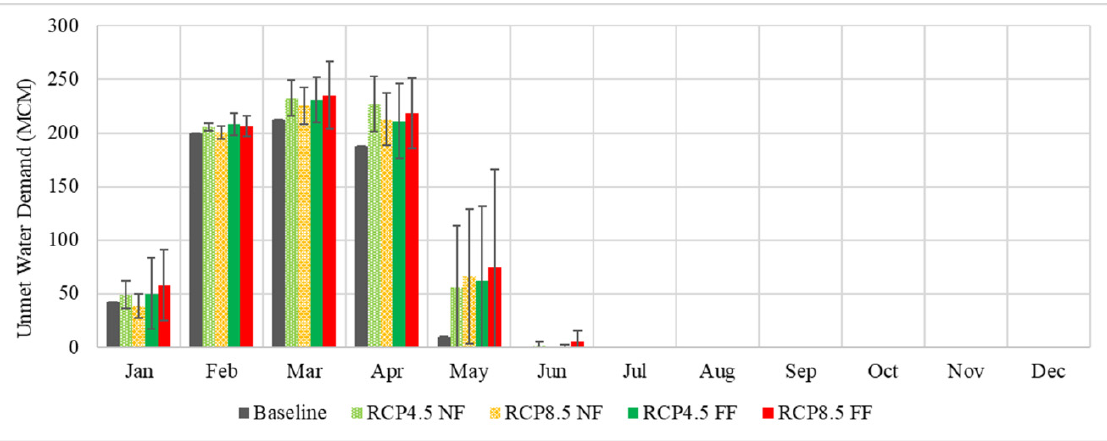
Figure 14. Unmet agricultural water demands (MCM) in the SRB during baseline and future scenarios. Error bars show the standard deviation among the GCMs.